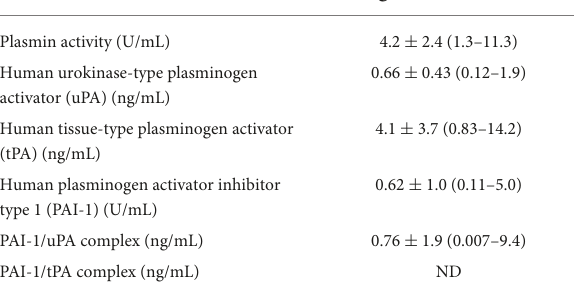
TABLE 2 Measurements for the plasmin system in human milk from all lactating women in the study.